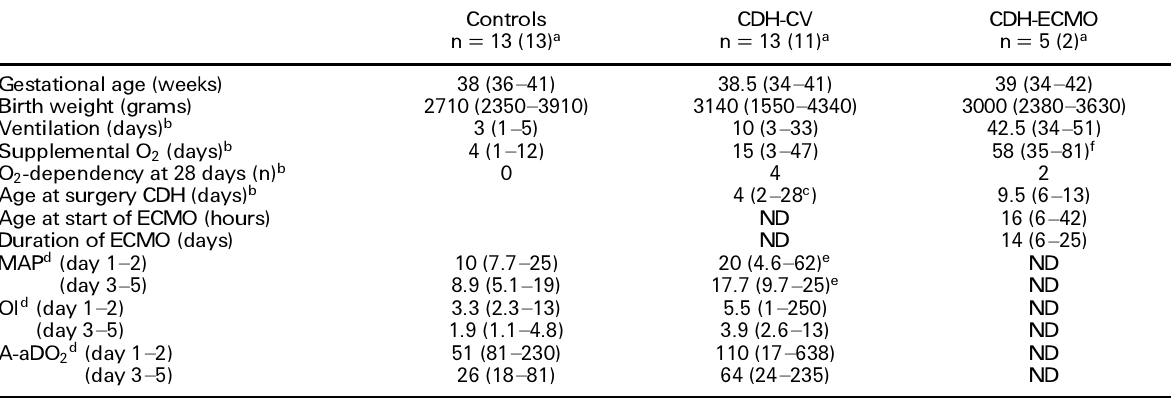
Table 1. Characteristics of control subjects and CDH